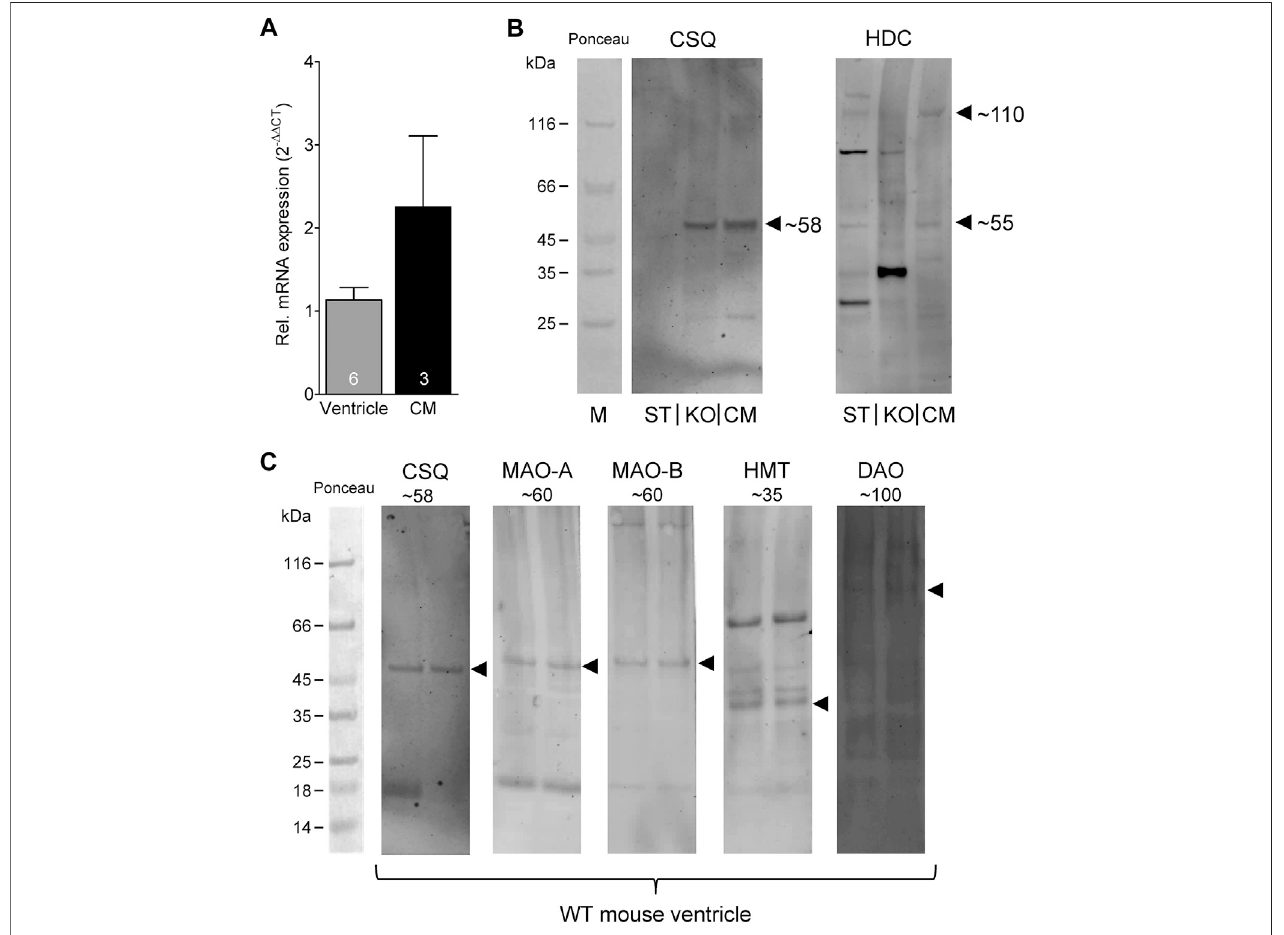
FIGURE 6 | Detection of histamine metabolizing enzymes. (A) By real time reverse transcription PCR, expression of HDC mRNA could be detected in mouse ventricular samples as well as in isolated cardiac myocytes (CM). Numbers in bars indicate number of animals studied. (B) Representative Western blots for HDC demonstrateitspresenceinisolatedmousecardiacmyocytes(CM)initsactive53 kDaform(notethehomodimeratabout110 kDa).Amousestomachsample(ST)was used as positive control and a cardiac sample of a HDC knockout mouse (KO) as negative control. Cardiac calsequestrin (CSQ) was used as loading control especiallyforcardiac samples(notethemissingbandinST). (C) RepresentativeWestern blotsforCSQ(loadingcontrol),MAO-A,MAO-B,HMTandDAO(extremelylow amounts)ofmousetissuehomogenates.Thecorrespondingmolecularweightofeachenzymeisindicated.Forbetterorientation,theponceaustainedmolecularweight marker is